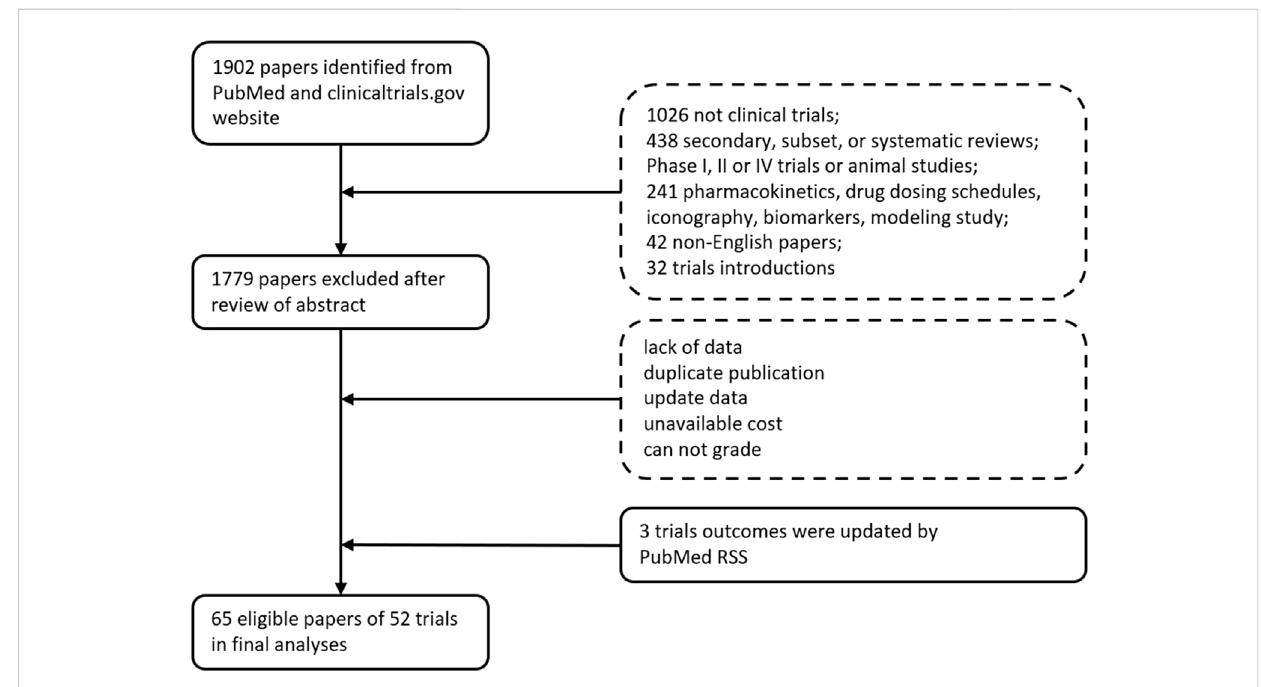
FIGURE 1 Identi fi cation of RCTs of all therapy in six immune checkpoint inhibitors.